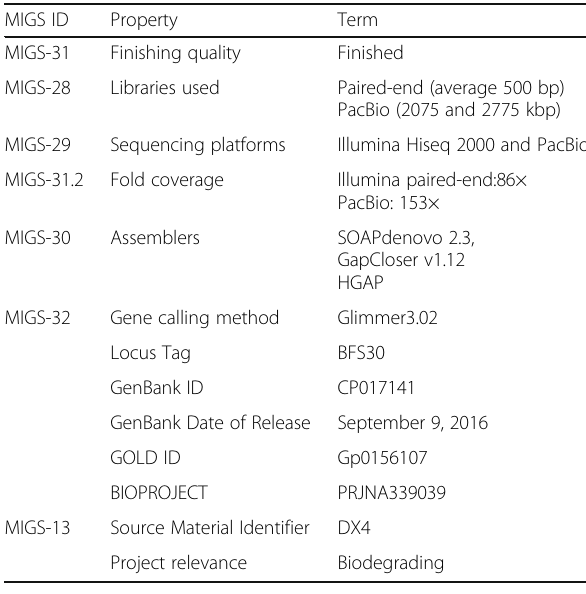
Table 2 Project information of the whole genome sequence of P. steynii DX4